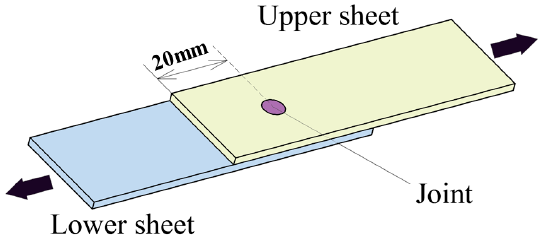
Figure 5. Specimen used for shearing test.